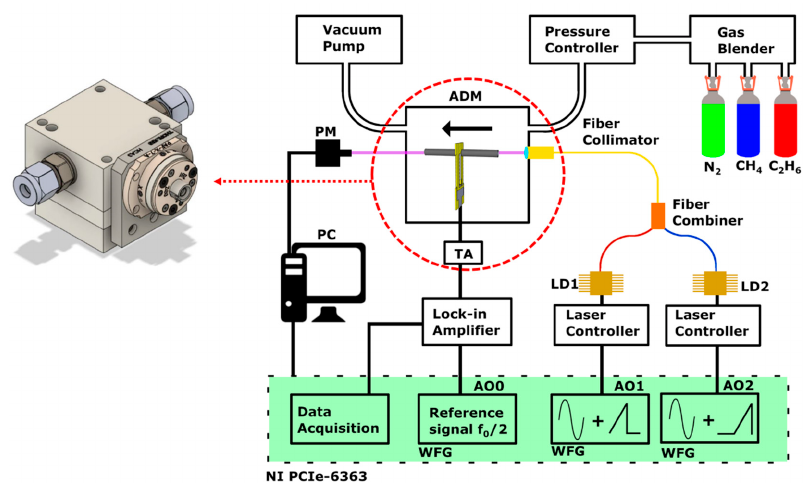
Figure 1. Schematic of the experimental apparatus: ADM—acoustic detection module, LD1—laser diode 1, LD2—laser diode 2, TA—transimpedance amplifier, PM—power meter, PC—personal computer, WFG—waveform generator. The black arrow indicates the gas flow through the ADM. A detailed design of the fiber-coupled ADM is also shown.